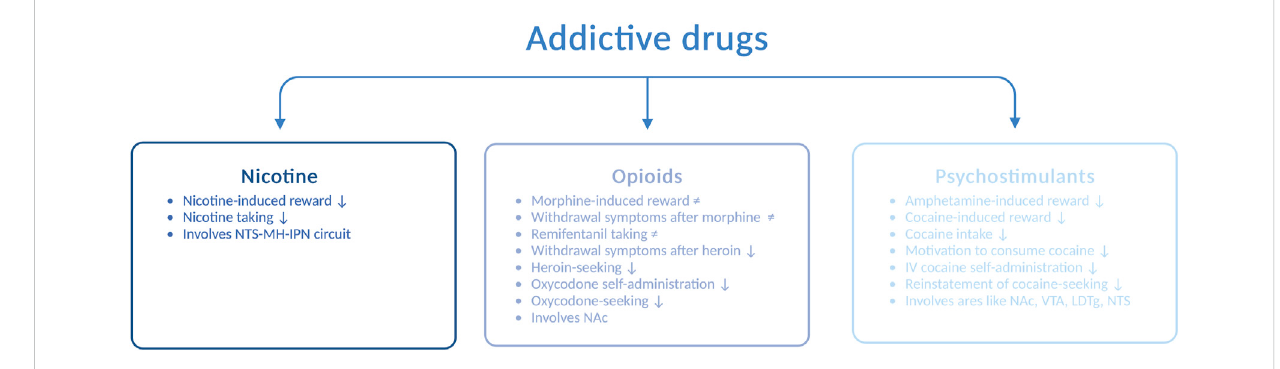
FIGURE 3 Schematic illustration of various drug-related responses that are reduced ( ↓ ) or unaltered ( ≠ ) by GLP-1 receptor agonists. Abbreviated are the nucleus of the solitary tract (NTS), medial habenula (MH), interpeduncular nucleus (IPN), nucleus accumbens (NAc), ventral tegmental area (VTA), laterodorsal tegmental area (LDTg), and intravenous (IV); the illustration is created using